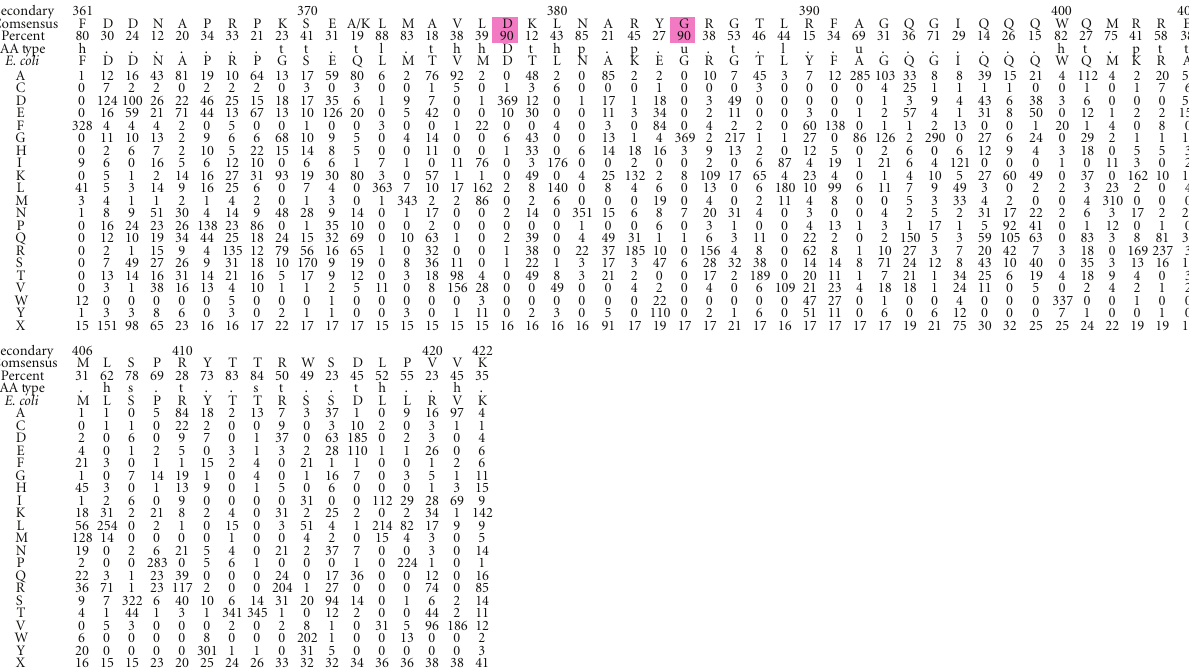
Figure 2: Preferred amino acid at the 408 amino acid positions in UmuC(V), which is the polymerase subunit of DNAP V. Top row: amino acid numbering (every tenth residue) and the likely secondary structure based on alignment to other Y-Family DNAPs ( β -strand, yellow; α -helix, blue, turn, green). Second row: consensus amino acid. Third row: percentage of the consensus amino acid. Fourth row: consensus type of amino acid, as codified in [101] (Website: http://coot.embl.de/Alignment/consensus.html). Regions where the consensus is high are highlighted in pink (all Y-Family DNAPs) or red (UmuC(V) only). Fifth Row: UmuC(V) sequence from E. coli . Rows 6–25 show the number of amino acids of each type at each position using the conventional one-letter code. Row 26: We note that some UmuC(V) sequences have slightly more or fewer than 422 amino acids. The number of UmuCs with an amino acid missing at a position compared to E. coli is shown in Row 26 (“X”). When an amino acid is present in a UmuC(V) but absent in E. coli , then the sequence is merely not included in Figure 2 (see text). In terms of gaps, E. coli only has one position that does not conform to the majority of UmuC(V)s: E. coli has an amino acid at position 156 (W), which is not present in a slight majority of all UmuC(V)s (226/408). The 408 UmuC(V) sequences were taken (as of 6/21/10) from the databases UniProt/Trembl [102] and HAMAP [103]. The sequences were aligned using MUSCLE [104]. Sequences were excluded for three reasons: (1) they were incomplete (i.e., sequences without recognizable versions of the N-terminus and the C-terminus were excluded); (2) they lacked any of the catalytic residues D6, D101, or E102; (3) they were redundant within a species (i.e., within a species if two UmuCs had the identical sequence, then only one was